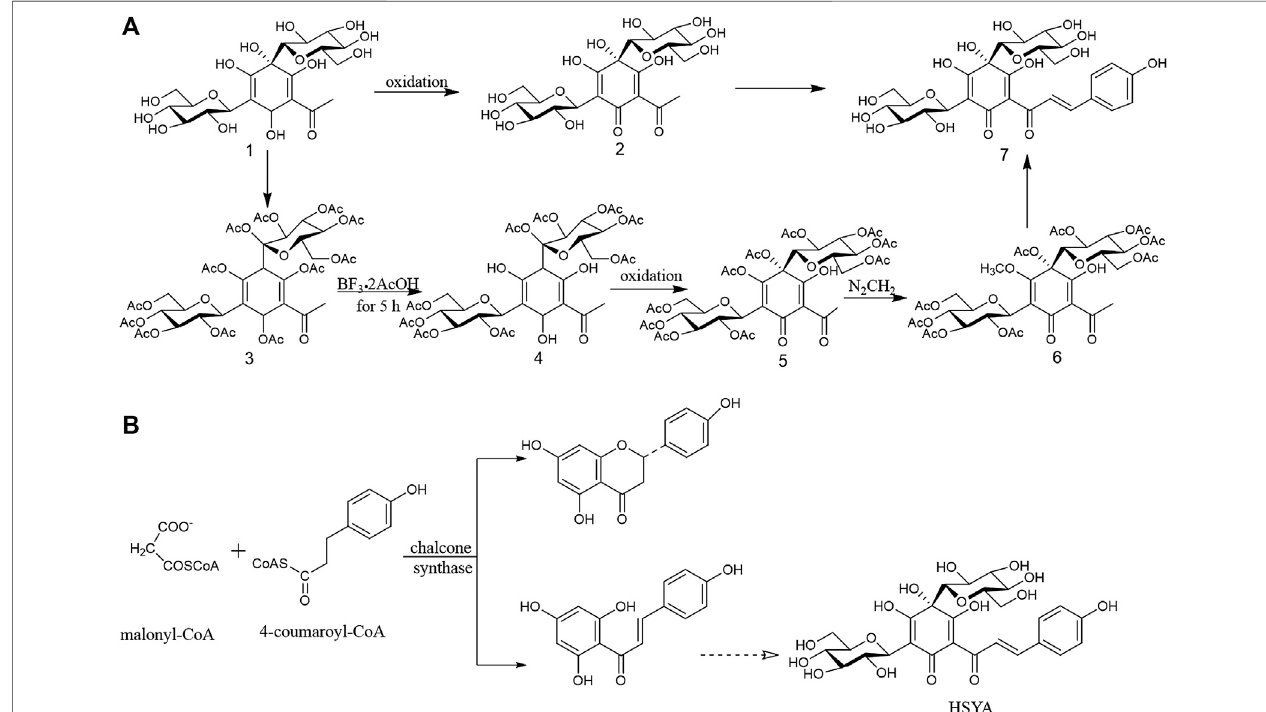
FIGURE 2 | (A) Oxidative synthesis pathway of HSYA; (B) The possible biosynthetic pathway of HSYA in phytosomal.